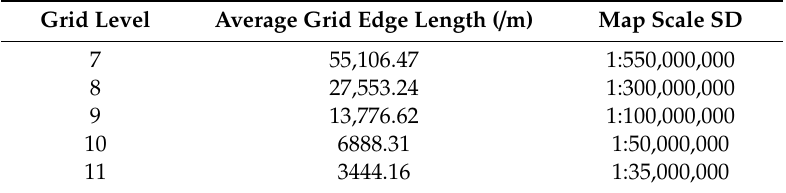
Table 1. Map scale for each discrete level of the regular icosahedral triangular grid.